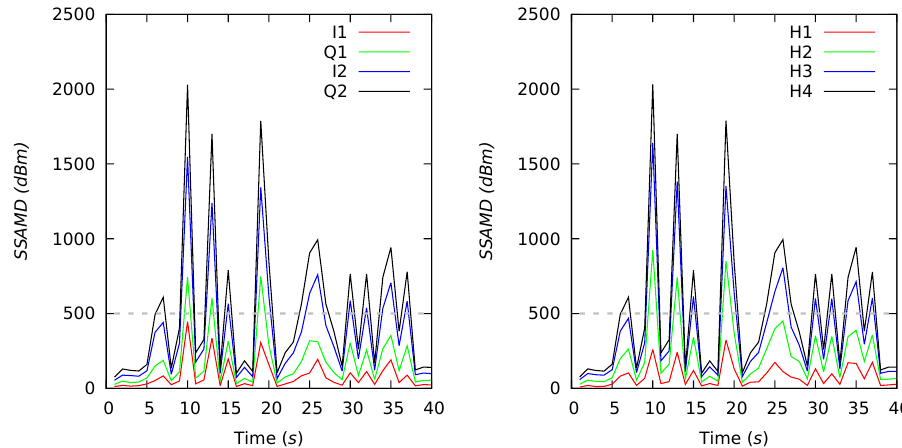
Figure A12. Experiment II, a small fly through the diffuser